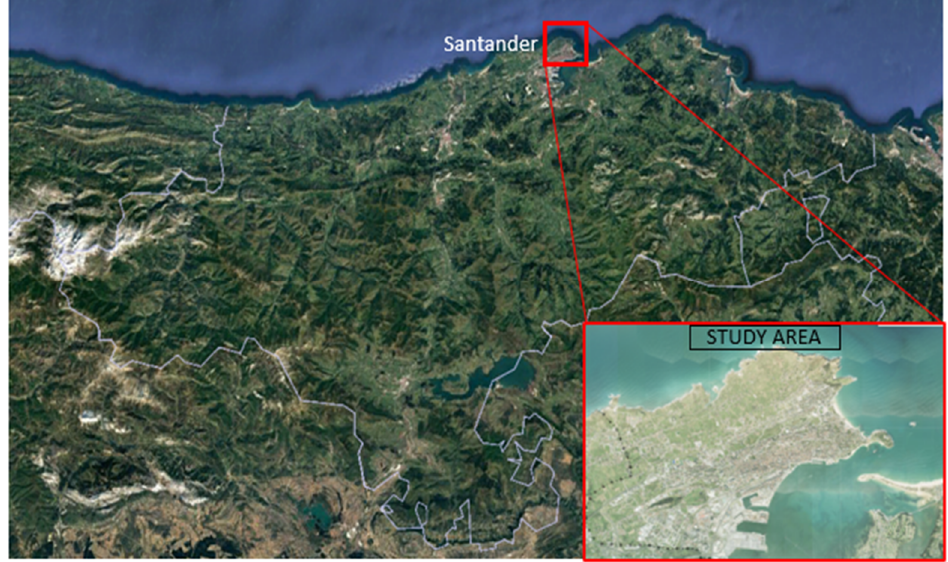
Figure 1. Location of the study area in the region of Cantabria (Spain) and delimitation of its borders (own elaboration).